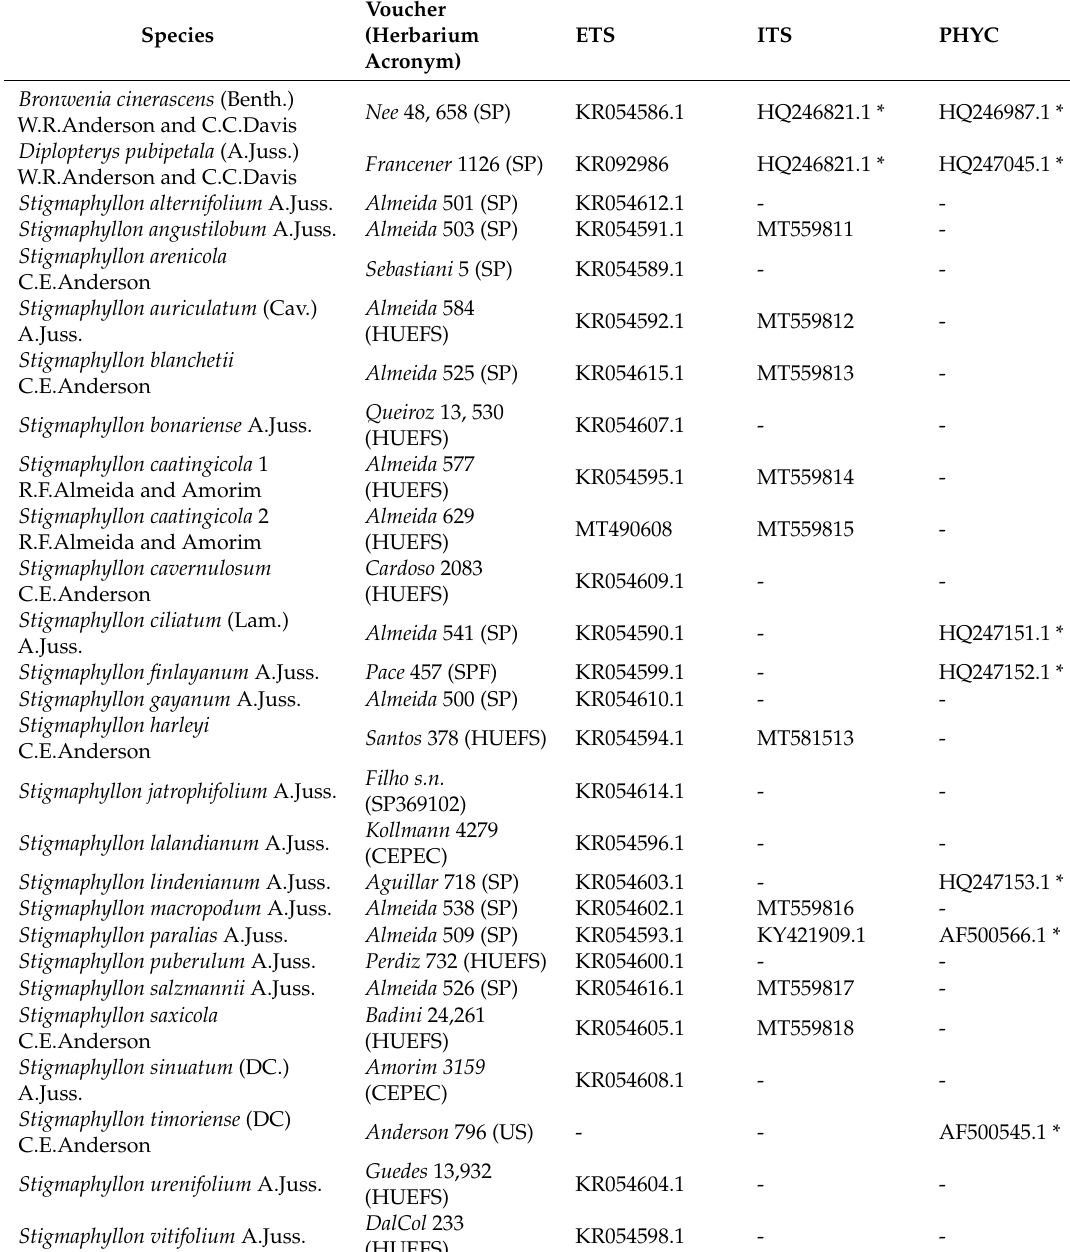
Table 3. Species and DNA regions sampled in this study. Genbank accession numbers are presented for columns ETS (External Transcribed Spacer), ITS (Internal Transcribed Spacer), and PHYC (Phytochrome C gene). * Sequences were obtained from